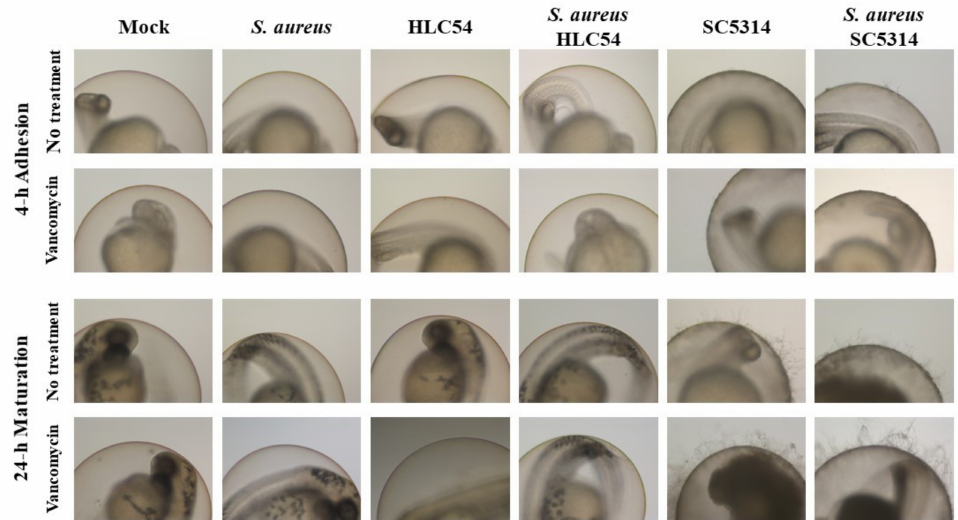
Figure 4. The morphology of mixed biofilm that are treated with S. aureus and C. albicans under vancomycin. After 4-h adhesion and 24-h maturation, fish embryos that were infected with S. aureus ATCC 29213, a hyphae-defective mutant HLC54, or wild-type SC5314 strains individually or mixed infected were photographed using a stereotactic microscope. Rows 2 and 4 share the same preparation of infected embryos but involve supplementation of 80 µ g/mL